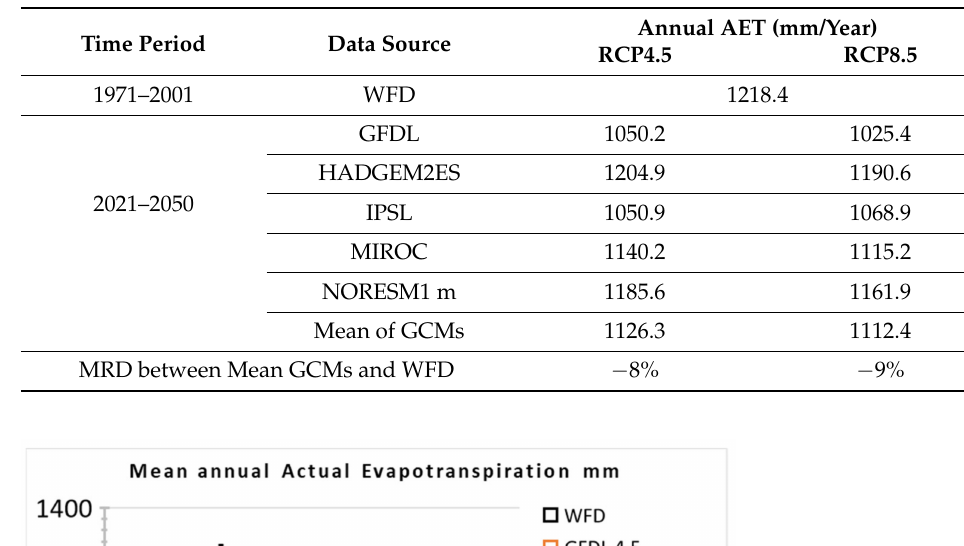
Table 4. Mean annual actual evapotranspiration in the reference period (WFD) and future period (each GCM and mGCMs), and the mean relative difference (MRD) between the GCMs’ mean and WFD.